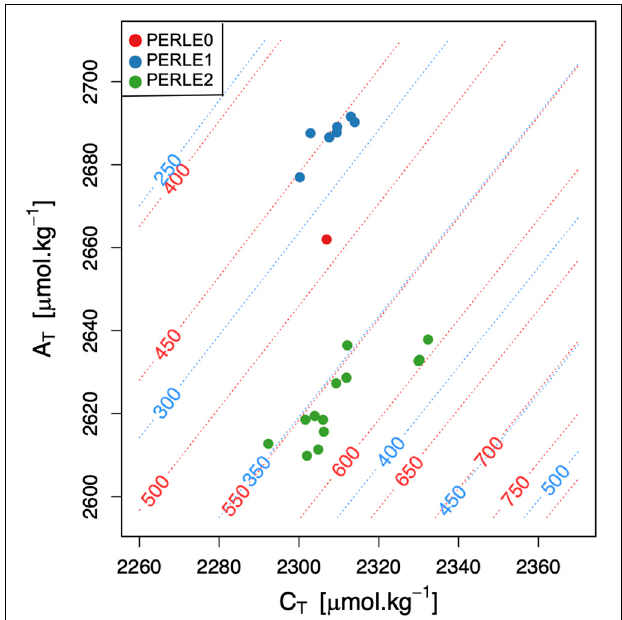
FIGURE 6 | Total alkalinity (A T ) vs. total dissolved inorganic carbon (C T ) within the MLD for all stations situated in the North Western Levantine Basin during the three PERLE cruises. Red and blue isolines indicate levels of constant p CO 2 SW as a function of A T and C T at 26 ◦ C and 15 ◦ C,